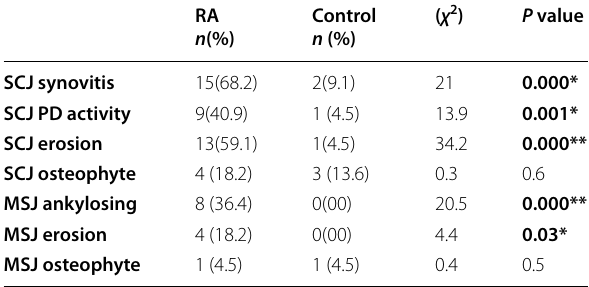
RA rheumatoid arthritis, n number, SCJ sternoclavicular joint, MSJ manibrusternal joint, χ 2 chi-square test, PD power Doppler signals * P value < 0.05 is